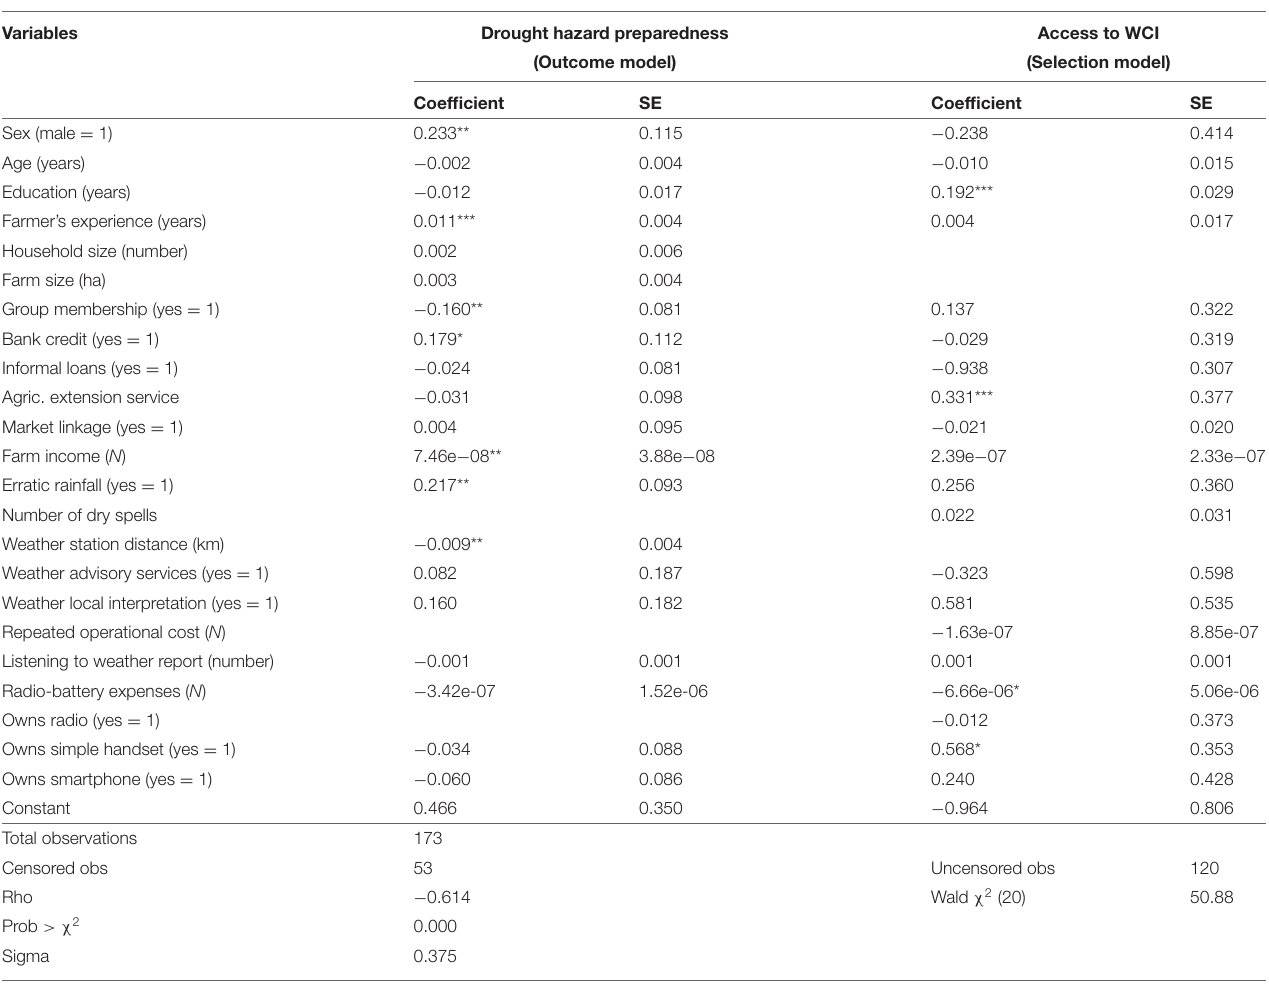
TABLE 5 | Heckman results of access to WCI and its usage in drought hazard